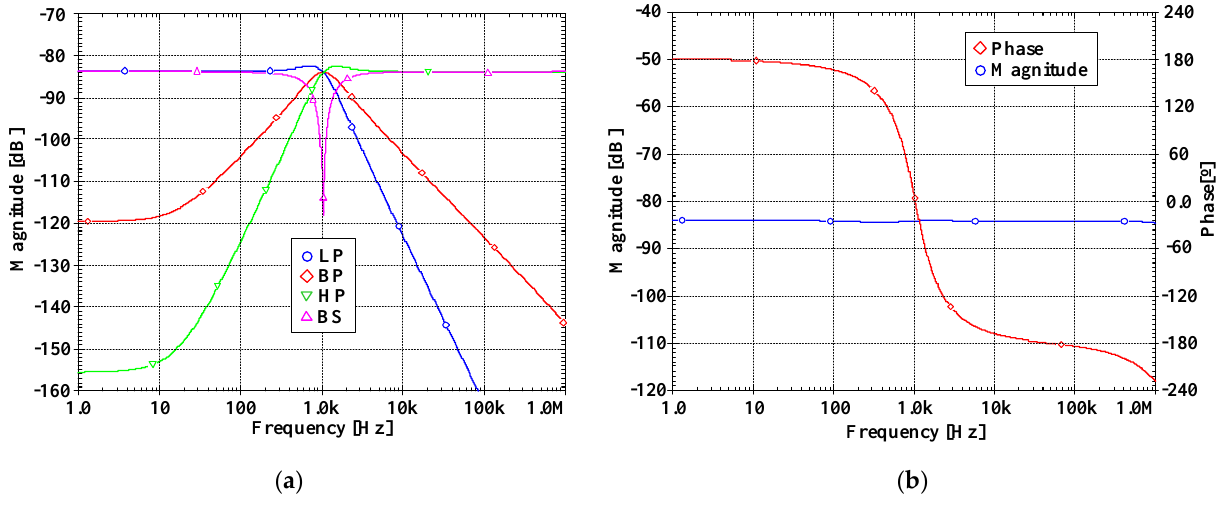
Figure 9. The simulated frequency responses of the TAM filter: ( a ) LP, BP, HP, BS filters; ( b ) AP filter.